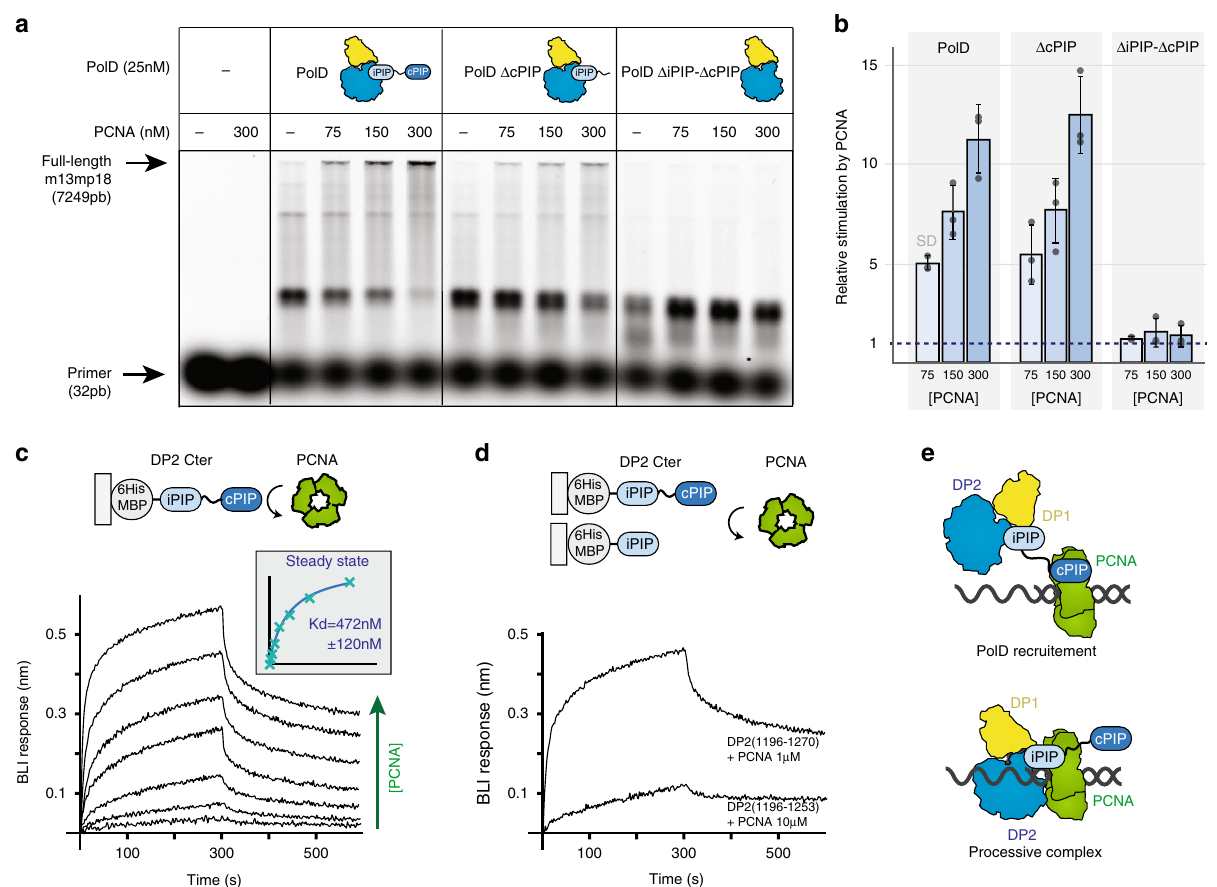
Fig. 4 The iPIP and cPIP PIP-boxes interact with PCNA through different mechanisms. a Primer extension studies were performed using M13mp18 template (7 nM), hybridized to a fl uorescent-labeled primer. Reactions contained 25 nM of DNAP, in the presence or absence of PCNA (75, 150, and 300 nM). b Quanti fi cation of the stimulation by PCNA of PolD wild type, PolD Δ cPIP, and PolD Δ iPIP- Δ cPIP. Histograms show full-length 7249 bp (%) for extension reaction in the presence of PCNA relative to full-length 7249 bp (%) without PCNA for each PolD. PolD wild type ( n = 3), PolD Δ cPIP ( n = 3), and PolD Δ iPIP- Δ cPIP ( n = 3). Error bars represent 1 SD. c Speci fi c binding of immobilized-DP2(1196 – 1270) to PCNA measured by biolayer interferometry (BLI). Steady-state analysis was performed using the average signal measured at the end of the association step (between 290 and 300 s). d Comparative binding of immobilized-DP2(1196 – 1270) and -DP2(1196 – 1253) to PCNA measured by BLI. The range of concentrations used in the binding experiments are listed in the Methods section. e Hypothetical two-steps mechanism for PCNA recruitment by PolD. Source data are provided as a Source Data fi